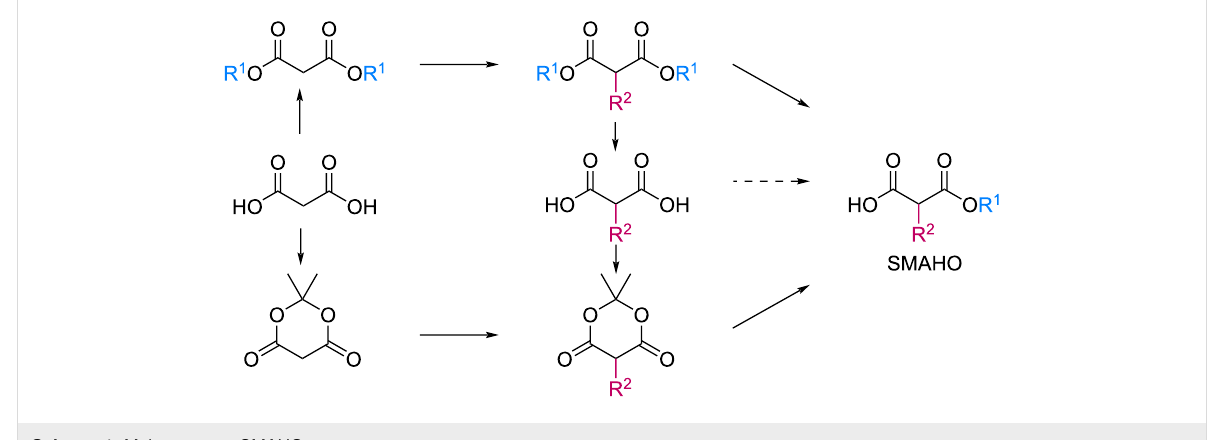
Scheme 1: Main routes to